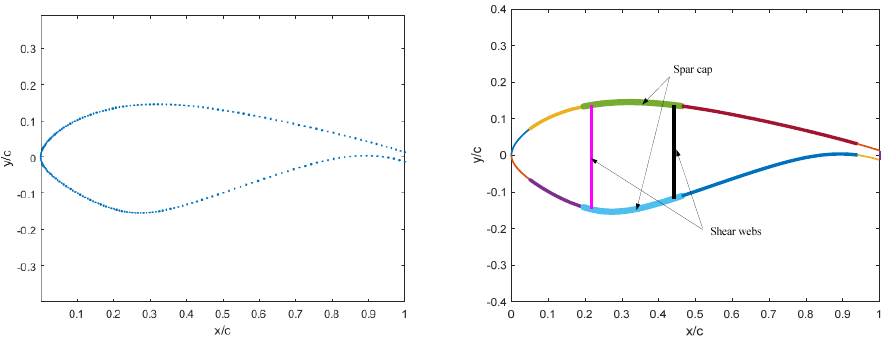
Figure 6. Typical structural parameters for section of the blade.